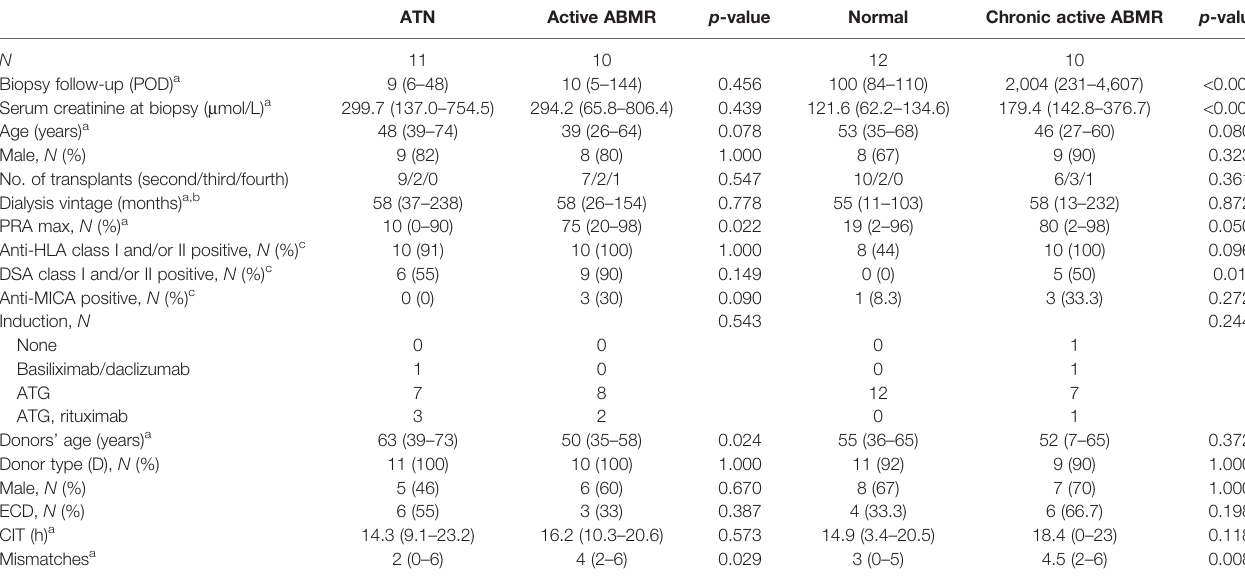
TABLE 1 | Patients ’ demographics and clinical characteristics according to the studied groups.